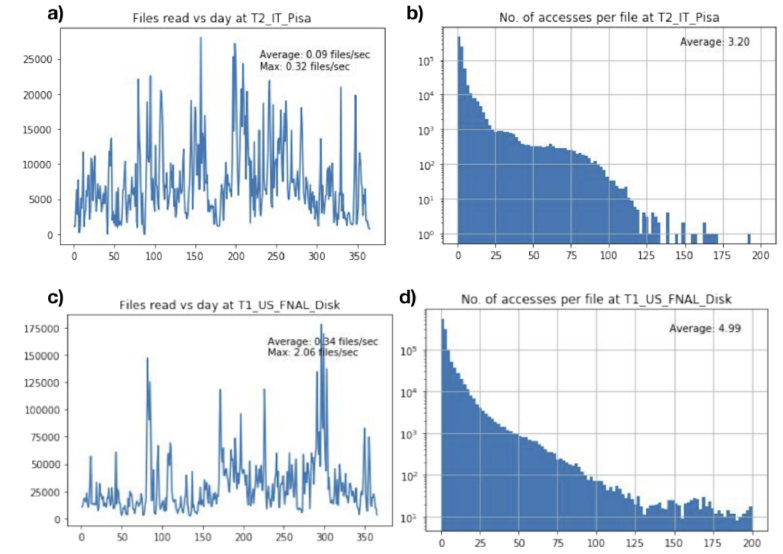
Figure 2. File popularity on a Tier-1 and a Tier-2 as a function of time (300 days). The plots above indicate that data is not accessed very often, it is most likely to be re-read within days after placement then the access drops substantially, almost two orders of